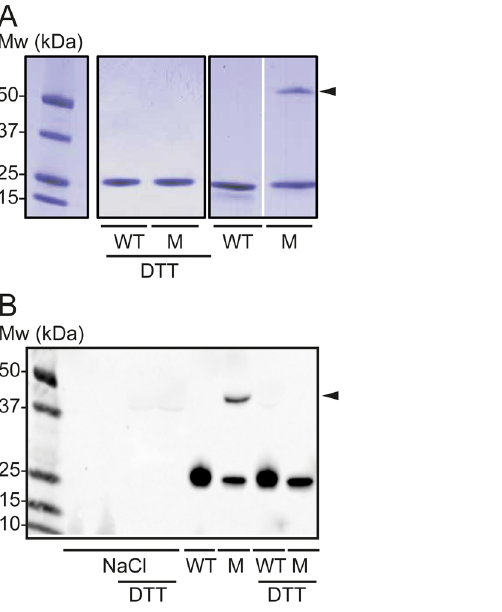
Figure 1. Covalent Cys-Cys binding and dimer formation of ApoAI-M. A , Purified apoAI-M (M) and apoAI-WT (WT) proteins (2 m g) were analyzed by SDS-PAGE (4–15% Tris-glycine) in the presence or absence of the reducing agent DTT. Formed apoAI-M dimers are indicated ( arrow ). B , Western blot analysis of apoAI-M (M) and apoAI-WT (WT) proteins in plasma samples from mice treated with the respective apoA-I protein. The SDS-PAGE separation was performed in the presence or absence of the reducing agent DTT to distinguish protein in covalently attached Cys-Cys dimers ( arrow ). Analysis of mouse plasma from control animals treated with saline (NaCl) was included to show specificity of the antibodies for human apoA-I protein. Data shown is representative of three experiments/animals.